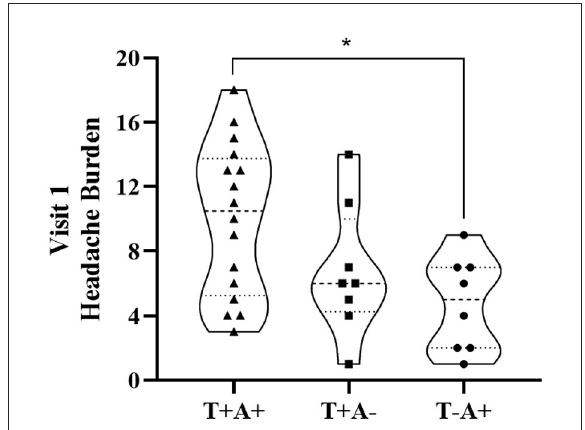
FIGURE1 Truncated Violin plot demonstrating Headache Burden at Visit 1 among RAMP1 + CALCA genoset groups. Each violin plot presents the group median (- - - -) and interquartile range ( ····· ). The truncation of plots represents the minimum and maximum observation for each group. The dark marks within each plot represent individual participant data. * p < 0.05.